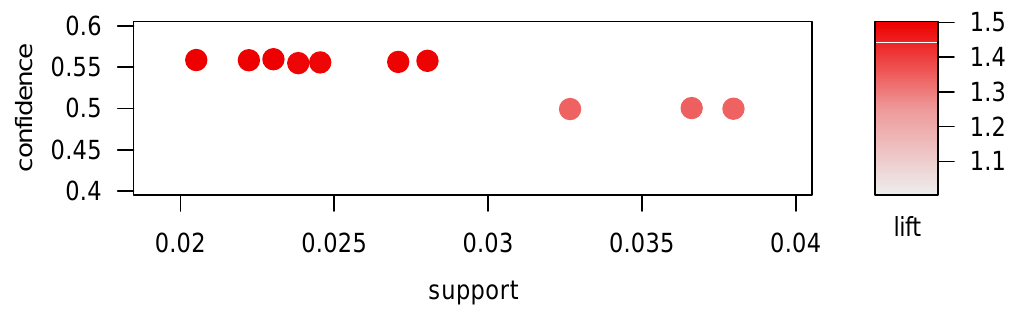
Figure 7. Relationships among support, confidence, and lift.